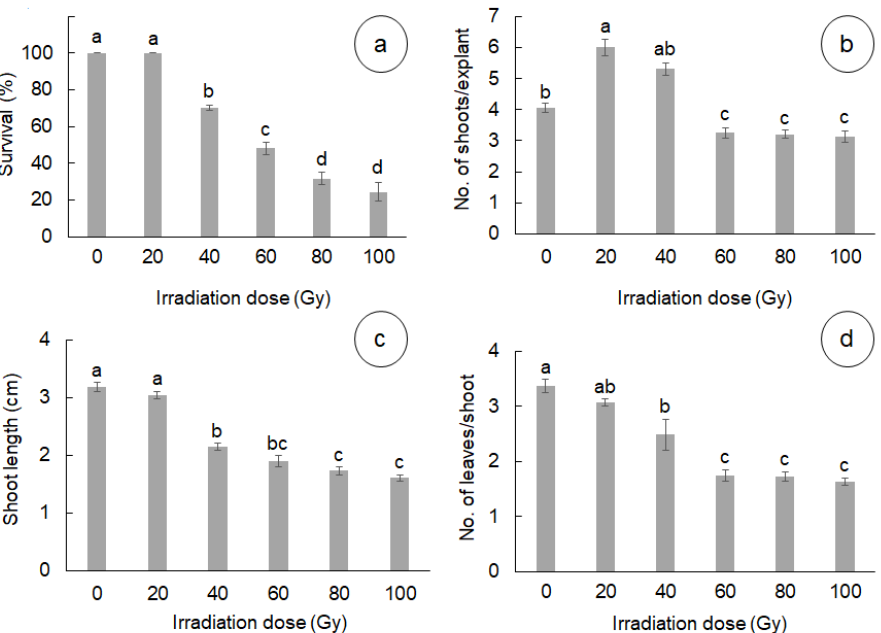
Figure 1. Effect of gamma radiation on in vitro survival and development of vanilla ( Vanilla planifolia Jacks. ex Andrews). ( a ) Survival percentage, ( b ) shoots per explant, ( c ) shoot length and ( d ) leaves per shoot at 60 d of culture. Values represent the mean ± standard error. Means with different letters are significantly different (Tukey, p < 0.05).